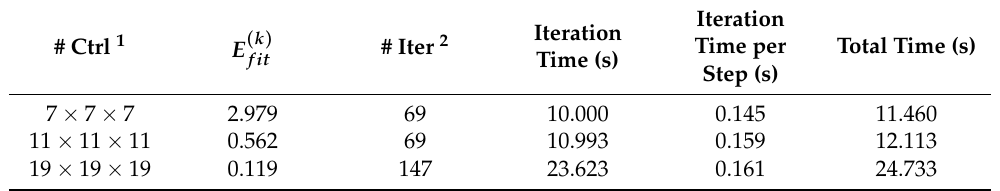
Table 3. Experimental data of Incre-IG-LSPIA algorithm with twice knot refinement. The number of collocation points is m = 30 × 30 ×